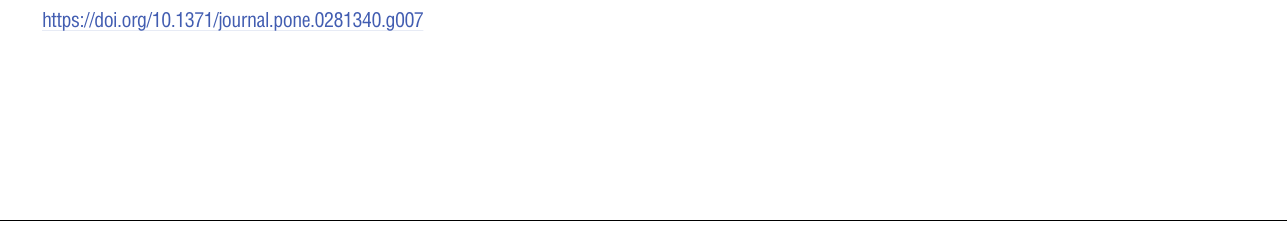
PLOS ONE | https://doi.org/10.1371/journal.pone.0281340 March 14, 2023 11 /